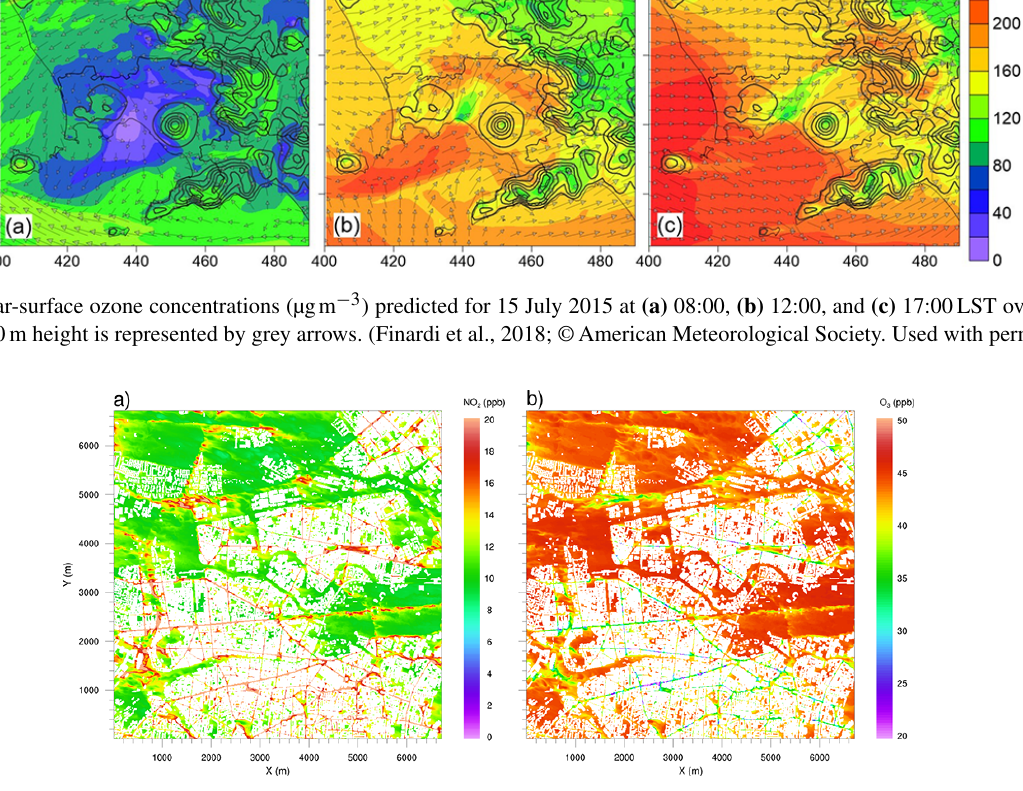
Figure 14. Modelled distribution of ground-level nitrogen dioxide (a) and ozone (b) at 20:00CEST for a 6 . 7km × 6 . 7km subarea of Berlin around Ernst-Reuter-Platz. The simulation was performed with the chemistry mechanism CBM4 and a horizontal grid size of 10m (Khan et al.,